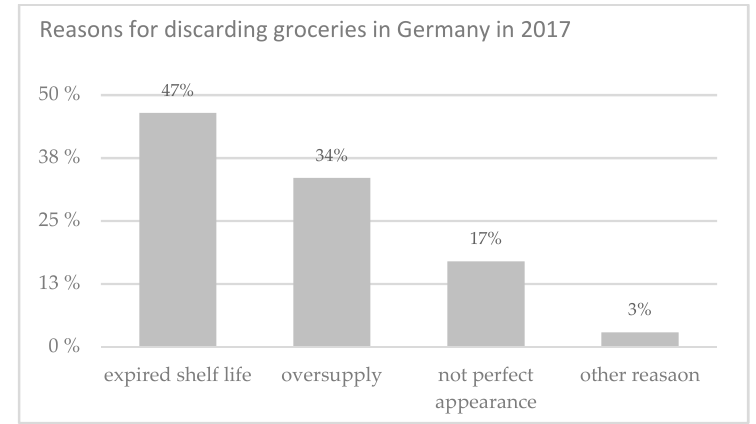
Figure 1. Reasons for discarding groceries in Germany in 2017, adapted from [7].